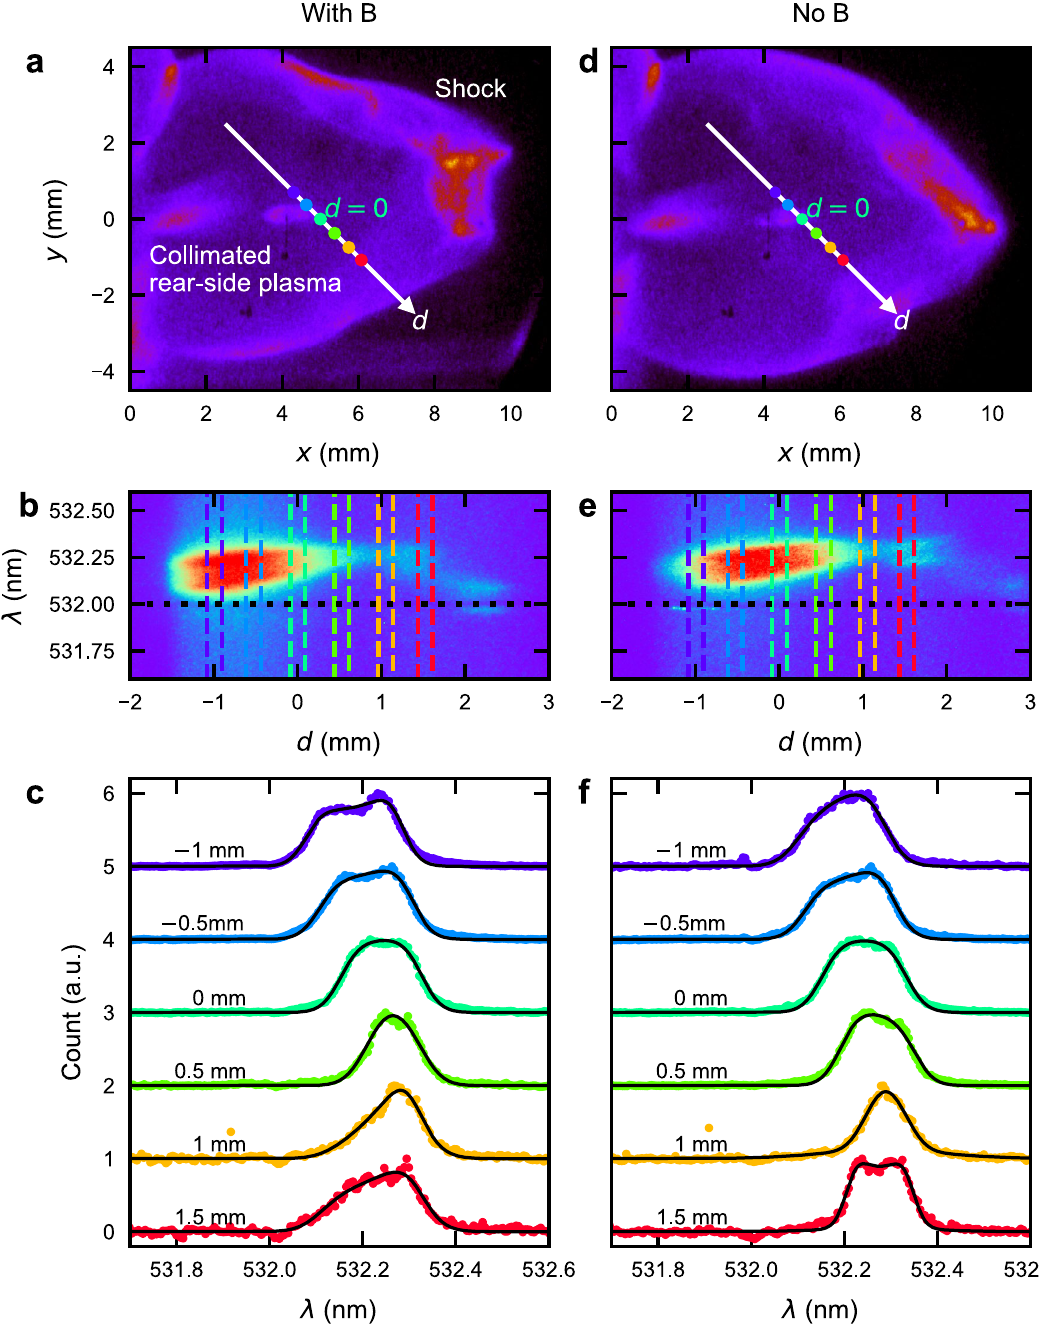
Figure 2. Local and global observations. Left ( (a–c) ) and right panels ( (d–f) ) are the measurements made with and without the applied magnetic field, respectively, in case1 taken 50 ns after the main laser interaction with the plastic foil target. ( a,d ) Transverse self-emission images. ( b,e ) CTS spectral images integrated over 2 ns, along direction d shown as a white arrow in ( a ) and ( d ). Note that d axis is actually in x − z plane as shown in Fig. 1b. If the plasma is cylindrically symmetric about x axis, the arrow corresponds to the probe. The vertical dashed- coloured lines indicated a 175 µ m -wide regions used to extract the space-resolved spectral cross-sections shown in ( c ) and ( f ). The horizontal dashed-black line at 532 nm is at the wavelength of the probe. ( c,f ) The spectral cross-sections intensities are normalized to 1. The fitting results are shown in black